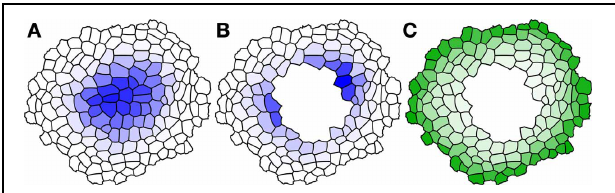
FIGURE 3 | Maintenance of organizing center during growth simulation. (A) Initial distribution of W ; (B) Distribution after 250 cell divisions; and (C) Distribution after 500 cell divisions. (D) Cell lineages; each color shows a different clonal population corresponding to all descendants of a particular cell in (A) . Parameters: k 1 = 2, k 2 = 0 . 2, k 3 = 1, k 4 = 0 . 25,